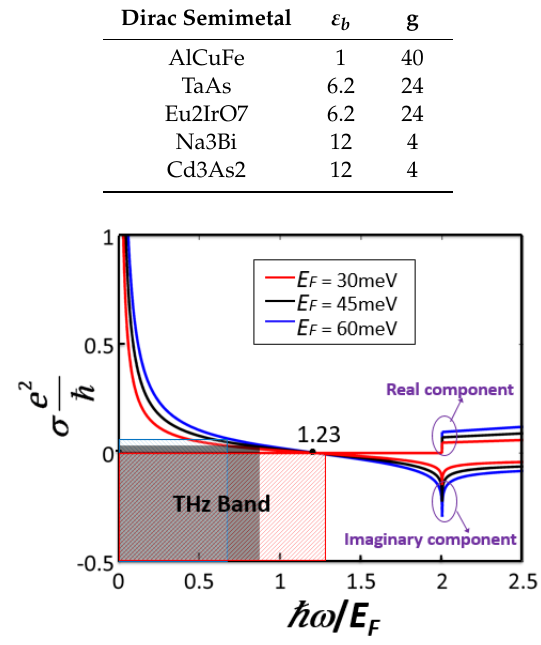
Figure 2. Normalized frequency-dependent conductivity of BDS.